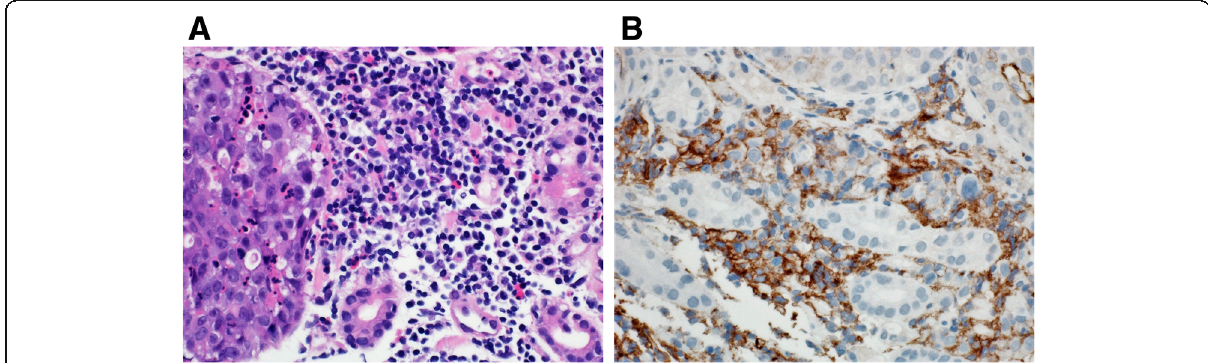
Fig. 13 A Case of poorly differentiated gastric adenocarcinoma. B Immunohistochemical staining of the tumor showing staining of tumor immune cells while tumor cells are predominantly negative. CPS: 20. (DAKO 22C3